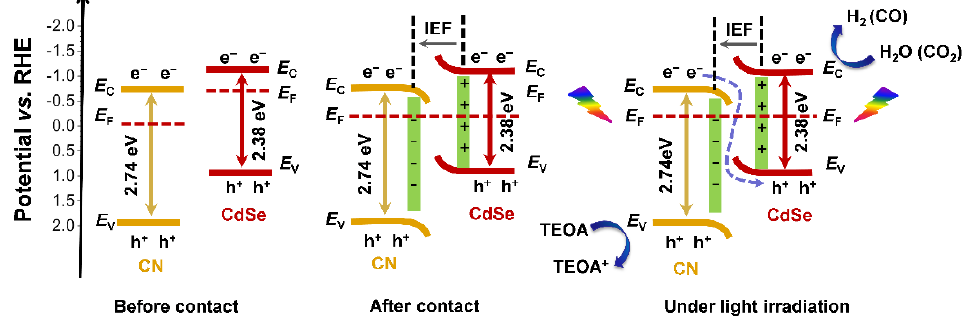
Figure 10. Schematic diagram of CdSe/CN composite for photocatalytic water splitting and CO 2 reduction using triethanolamine (TEOA) as a sacrificial agent and the formation of internal electric field (IEF). The potentials are relative to reversible hydrogen electrode (RHE).